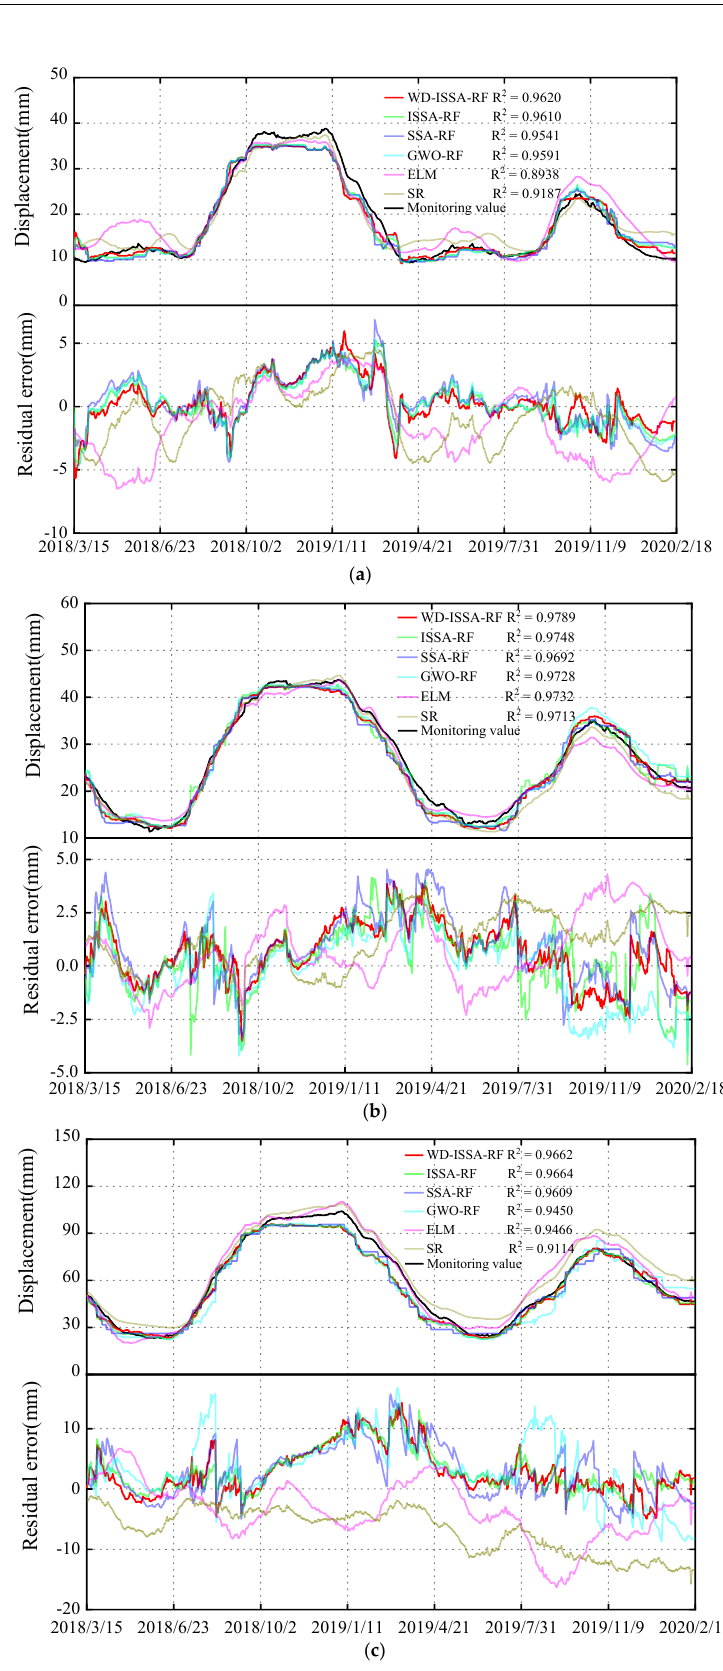
Figure 10. The predicted displacements and residuals of the six different prediction models for three monitoring points . ( a ) A09 - PL - 01. ( b ) A09 - PL - 02. ( c ) A19 - PL - 01.